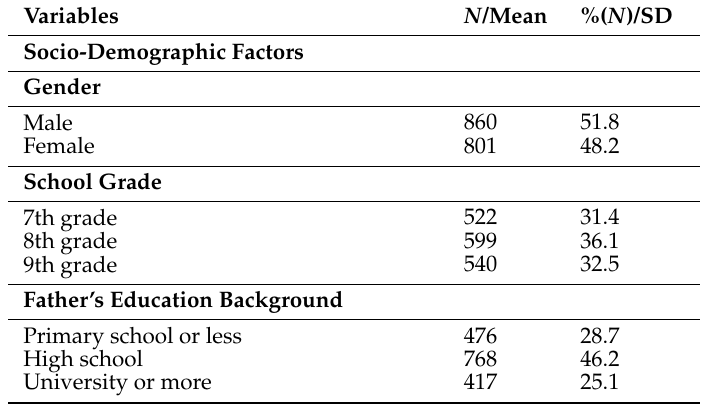
Table 1. Distribution of socio-demographic, Internet use, depressive symptoms and sleep disturbances ( N =